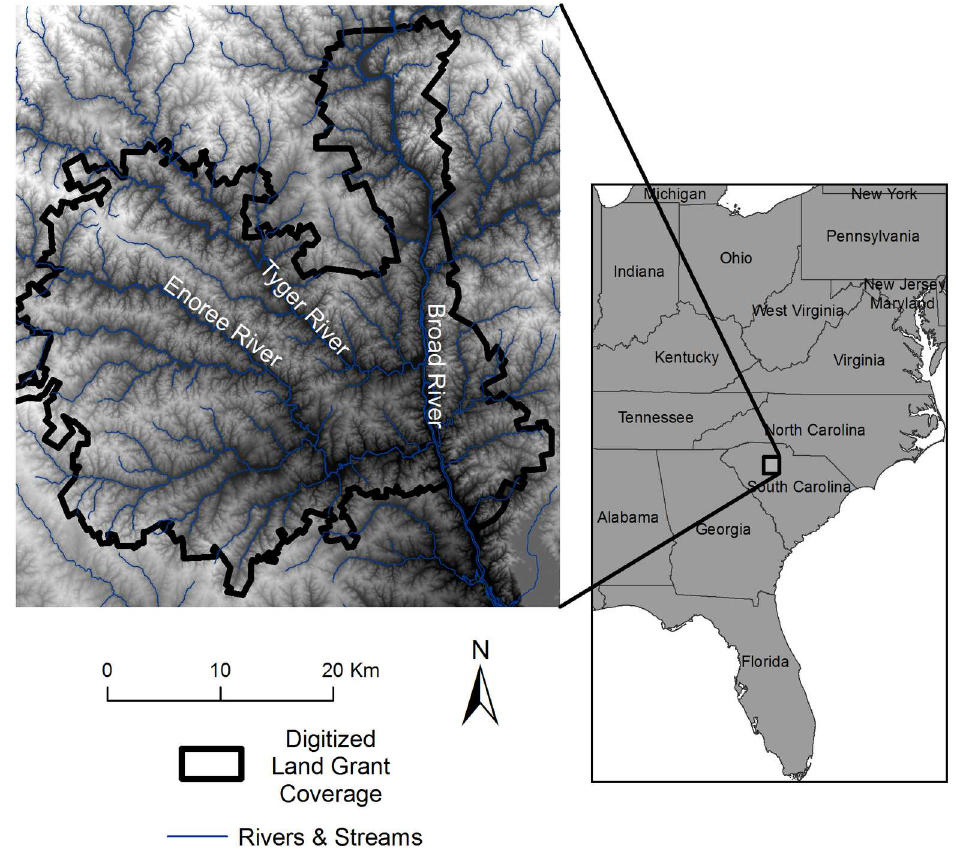
Fig 1. Location of project